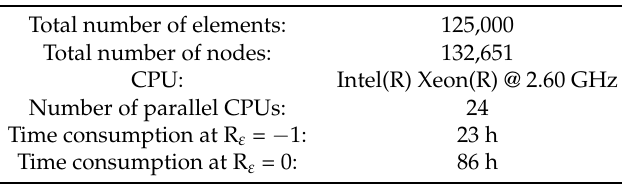
Table 4. Simulation environment and time consumption for one microstructural